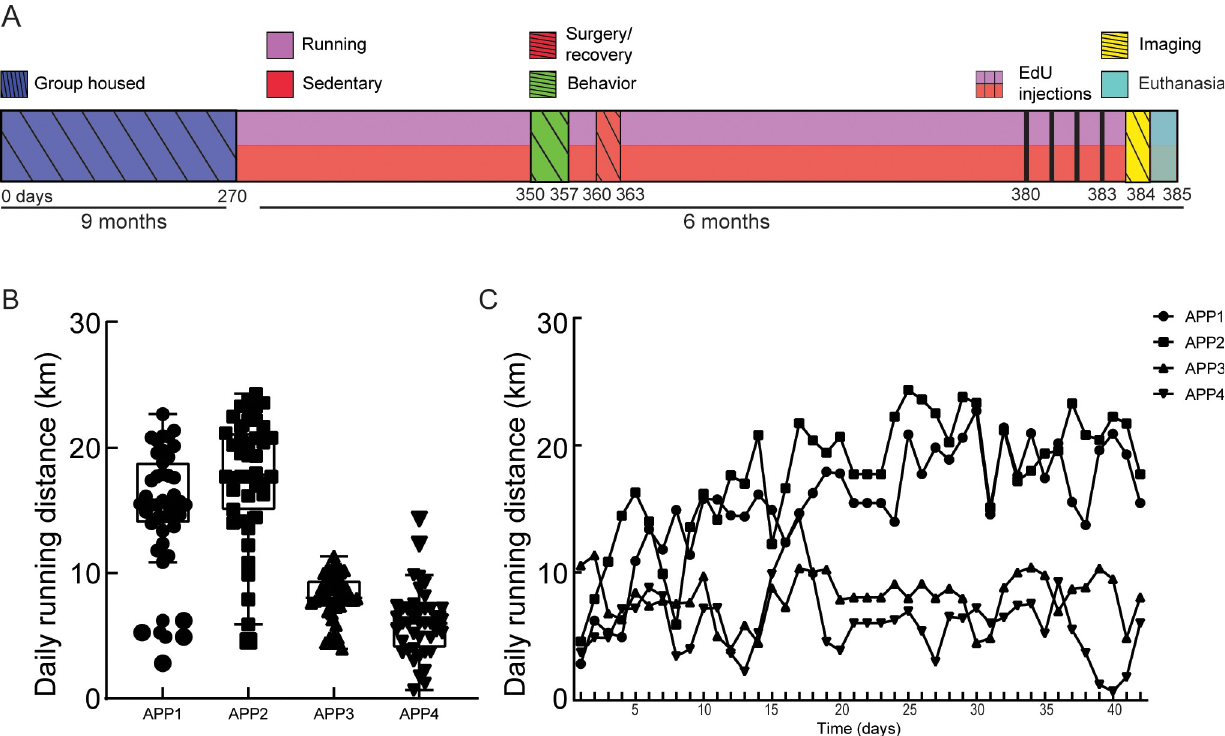
Fig 1. APP/PS1 mice reliably run when given unrestricted access to a running wheel in their home cage. A. Timeline of the study. After three months of voluntary exercise on a wheel running (or standard housing for the sedentary control group), mice underwent behavioral testing. Next, a craniotomy was performed, after which mice were allowed three weeks to fully recover. The cortical vasculature was then imaged with in-vivo two photon excitation fluorescence microscopy. Finally, after four consecutive days of EdU-injections, mice were euthanized. Harvested brain tissue was then used for immunohistochemistry. B. Each dot is the distance covered in km per day over 45 days for the four APP/PS1 mice in the running group. Data show mean + SD. C. Daily distance in km per day for the four APP/PS1 mice in the running group across time.